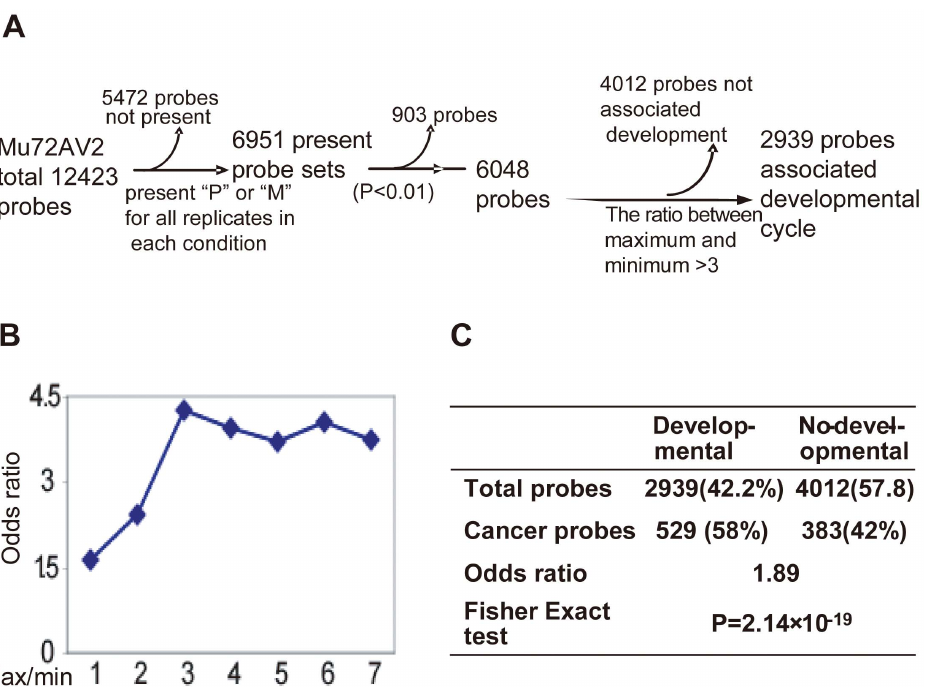
Figure 1. Definition of mammary gland developmentally associated genes. Overview of data processing for defining the developmentally associated gene subset was discribled in A. The probes were filtered systematically with different cutoffs:p value of gene expression among different time points and the optimal fold of maximum/minimum expression of a gene at different developmental time points, which should have a maximum Odds ratio of literature-based mammary gland-cycle associated genes in developmentally associated and non-developmentally associated genes subset. A higher Odds ratio means that a greater number of developmental genes were correctly classified. The figure B shows the curve of Odd ratios in the developmentally associated and non-developmentally associated genes subset defined by a cutoff with different ratio of maximum to minimum expression of each gene at different time points in the developmental progress. C. Fisher exact test to assess the frequency of validated cancer gene expression in the group of mammary gland developmentally associated genes. The validated cancer genes were obtained from previously published papers (File S5).